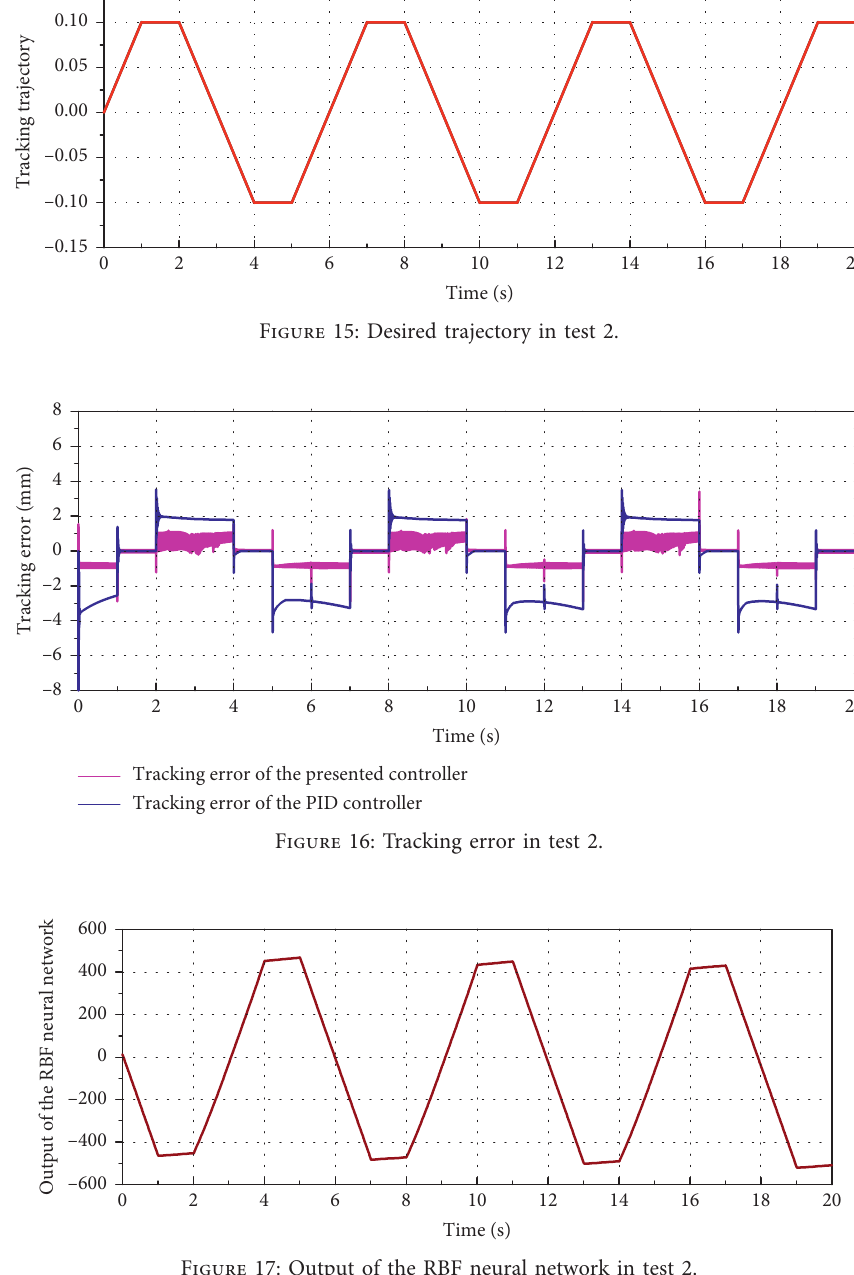
Figure 17: Output of the RBF neural network in test